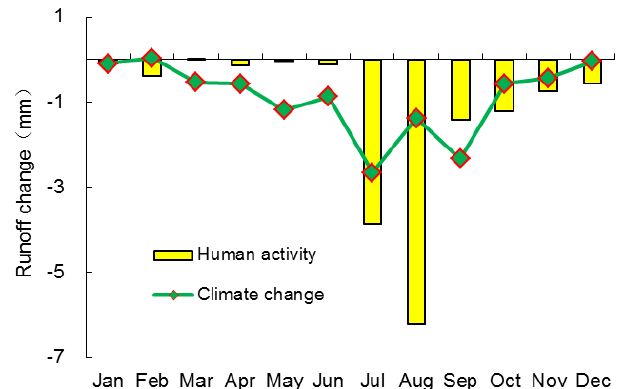
Figure 9. Impacts of climate change and human activity on seasonal distribution of runoff change.